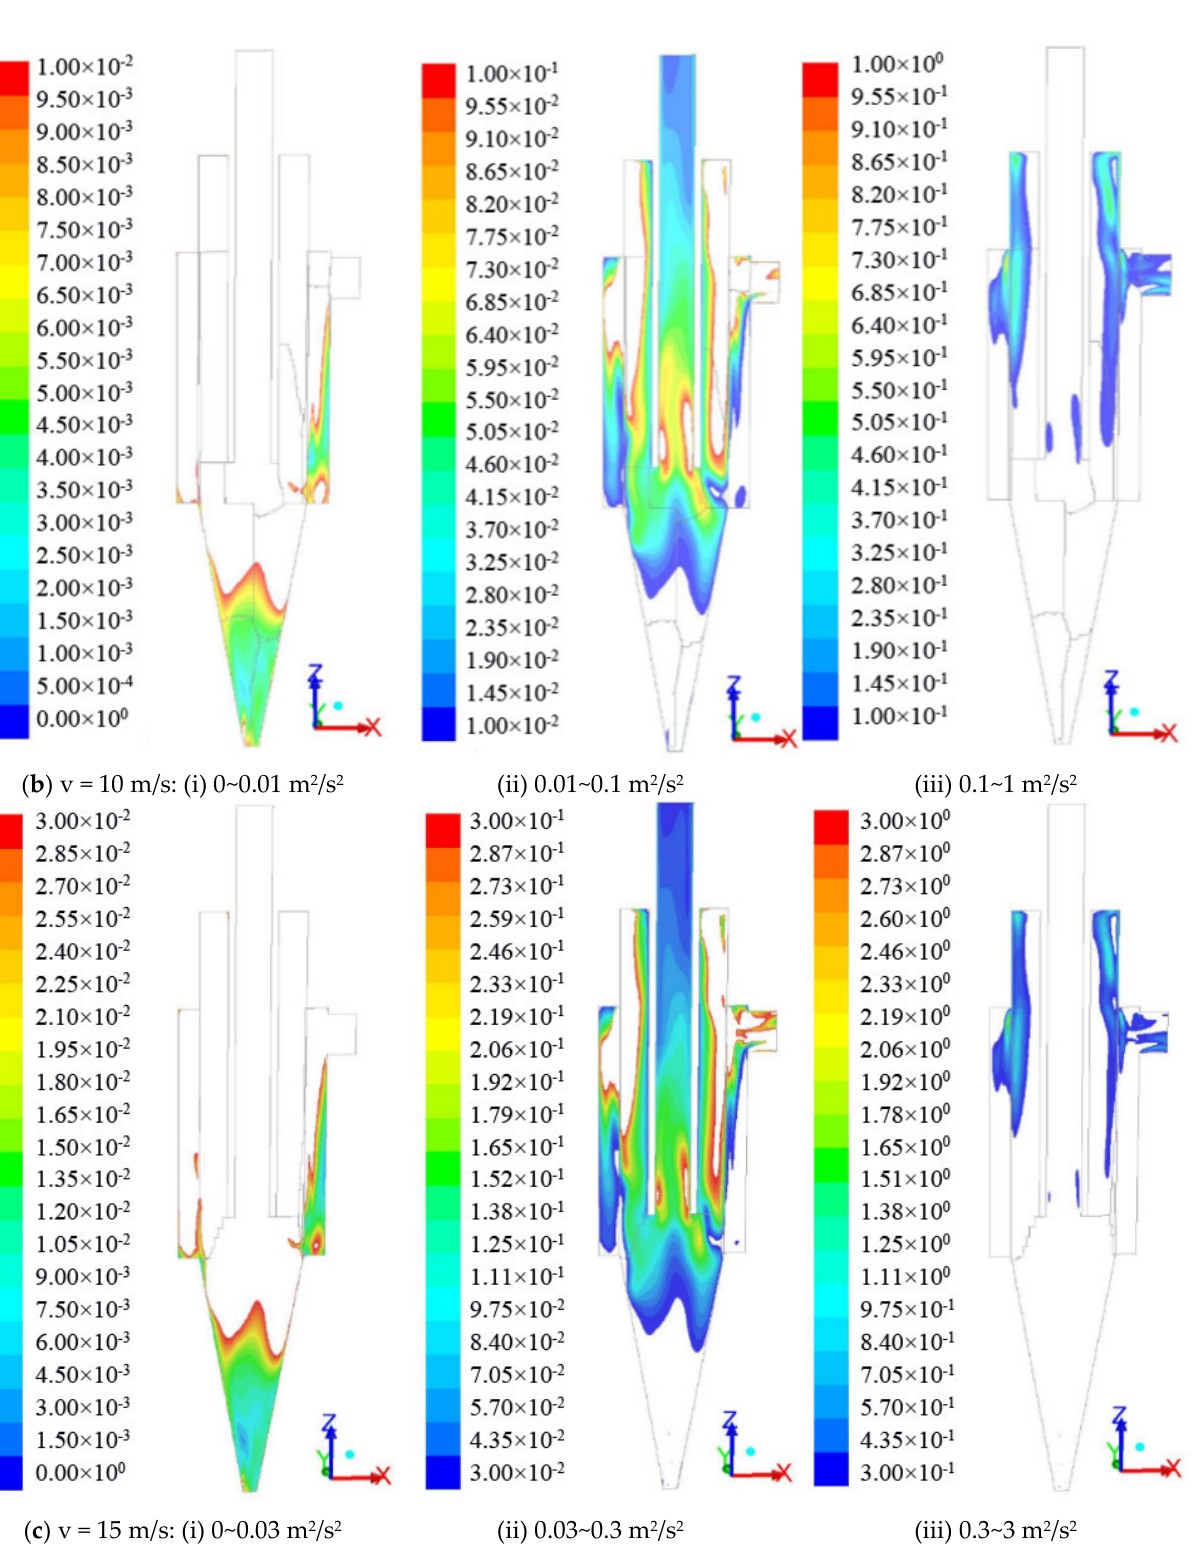
Figure 7. Distribution of turbulence kinetic energy k (m 2 /s 2 ) in TPHS.